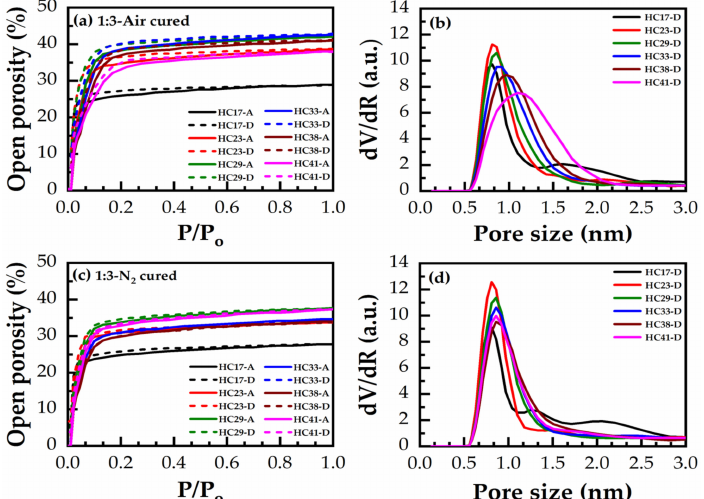
Figure 11. Heptane adsorption (A)/desorption (D) isotherms (heptane relative pressure, P/P o (ratio of current pressure P to saturated vapor pressure P o at room temperature) vs. open porosity) of 1:3 material ( a ) hard baked in the air for 30 min (air-cured) ( c ) hard baked in N 2 for 60 min (N 2 -cured), and the corresponding pore size distribution (PSD) in ( b , d ), respectively, calculated from desorption (D) isotherms, showing the effect of varying the porogen concentration from 17 to 41 wt% (films numbered from HC17 to